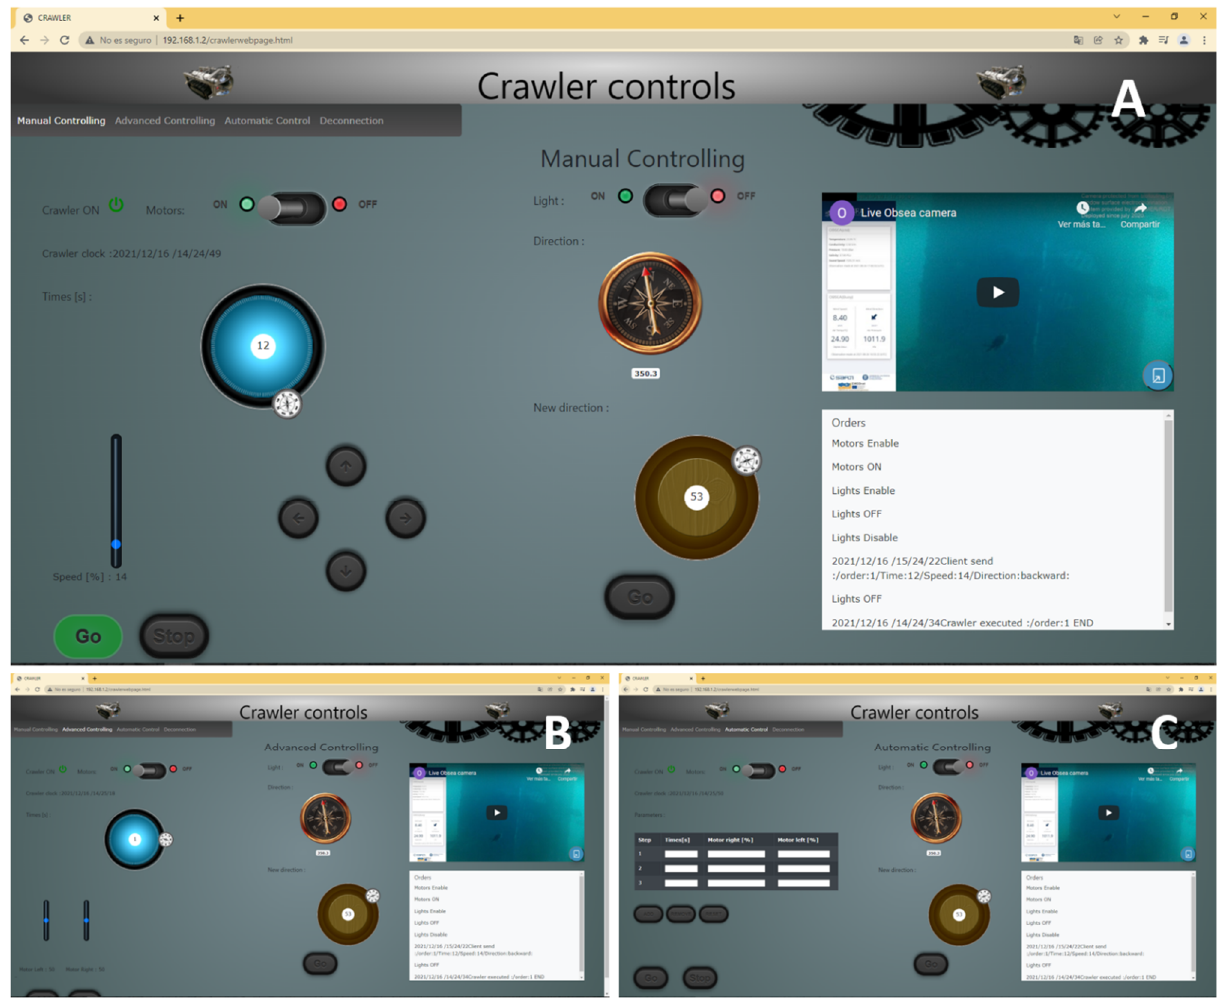
Figure 6. The web user interface for crawler control within the three different functioning modes: manual ( A ), advanced ( B ), and automatic modes ( C ).